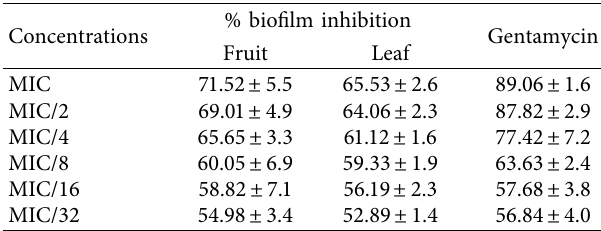
Table 7: Inhibition of pyoverdine secretion in P. aeruginosa by leaf and fruit essential oils of Vitex doniana